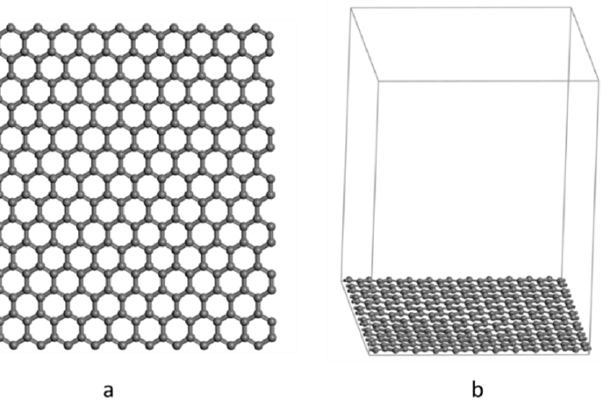
Figure 2. Representation of pristine graphene surface. ( a ) Graphite surface structure; ( b ) graphene structure with vacuum layer added.